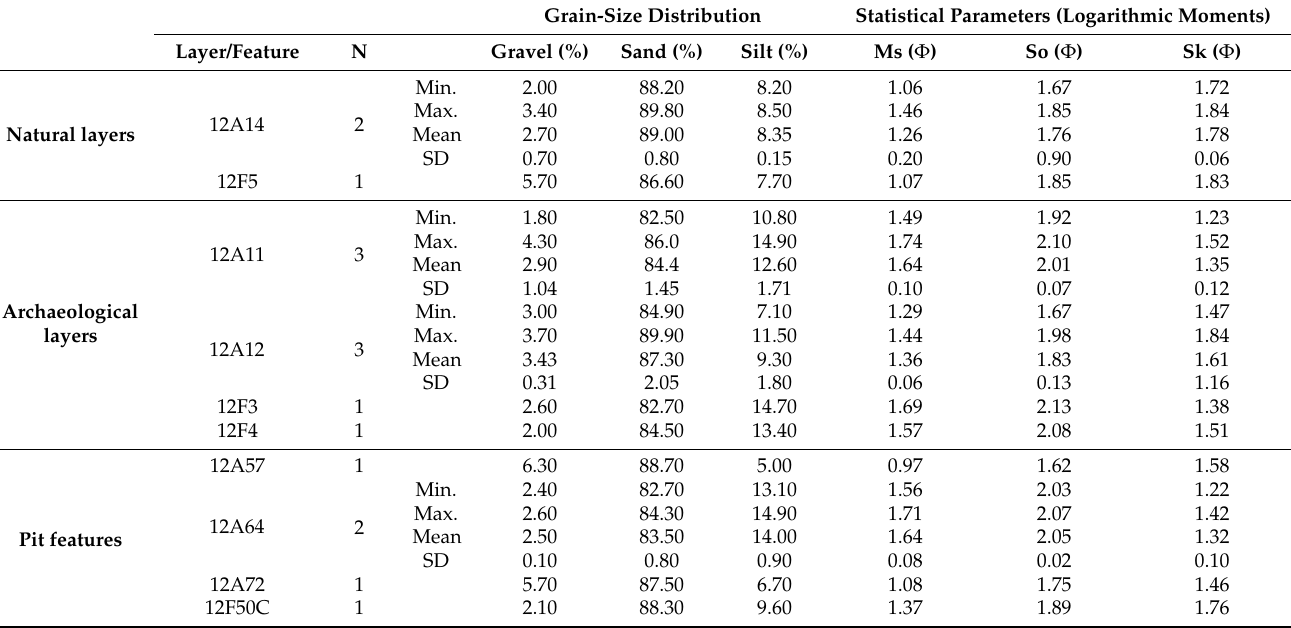
Table 3. Synthetic particle size data from sediment samples taken in areas 12A and 12F of the Fort Odanak site (CaFe-7).